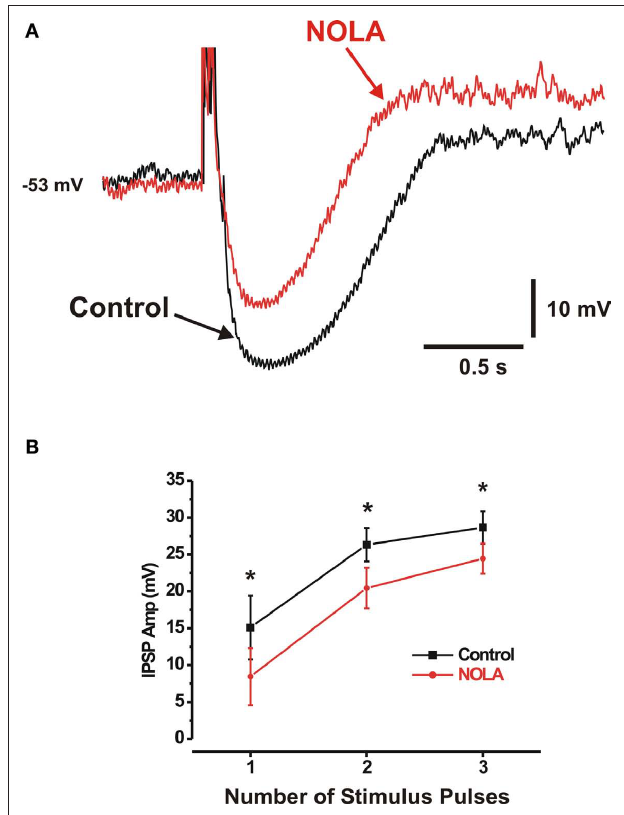
FIgurE 2 | Inhibition of endogenous NOS depresses IPSPs. (A) Three-pulse IPSP in control (black) and in the presence of NOLA (100 μM) (red) (B) Quantitative data; NOLA significantly reduced the amplitudes of 1-, 2- and 3-pulse IPSPs. * P < 0.05 (single-tailed t